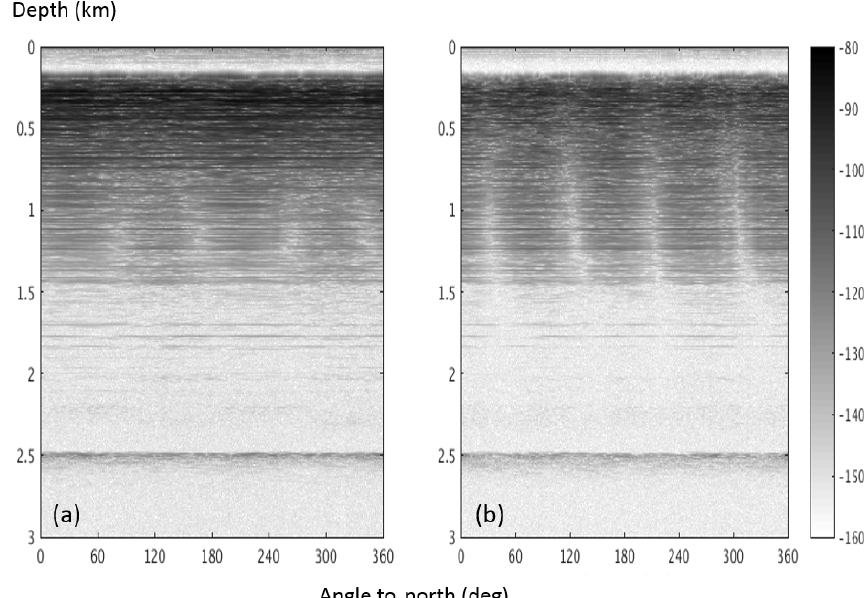
Figure 3. Multi-polarization measurements along Circle 3: (a) HH, transmit TX1, receive channels RX1, RX2, RX3, and RX4 combined; (b) HV, transmit TX1, receive channels RX5, RX6, RX7, and RX8 combined. The horizontal axis is the angle in degrees with respect to the local north, the vertical axis is ice depth in kilometers, and the color bar represents the relative power level in decibels.